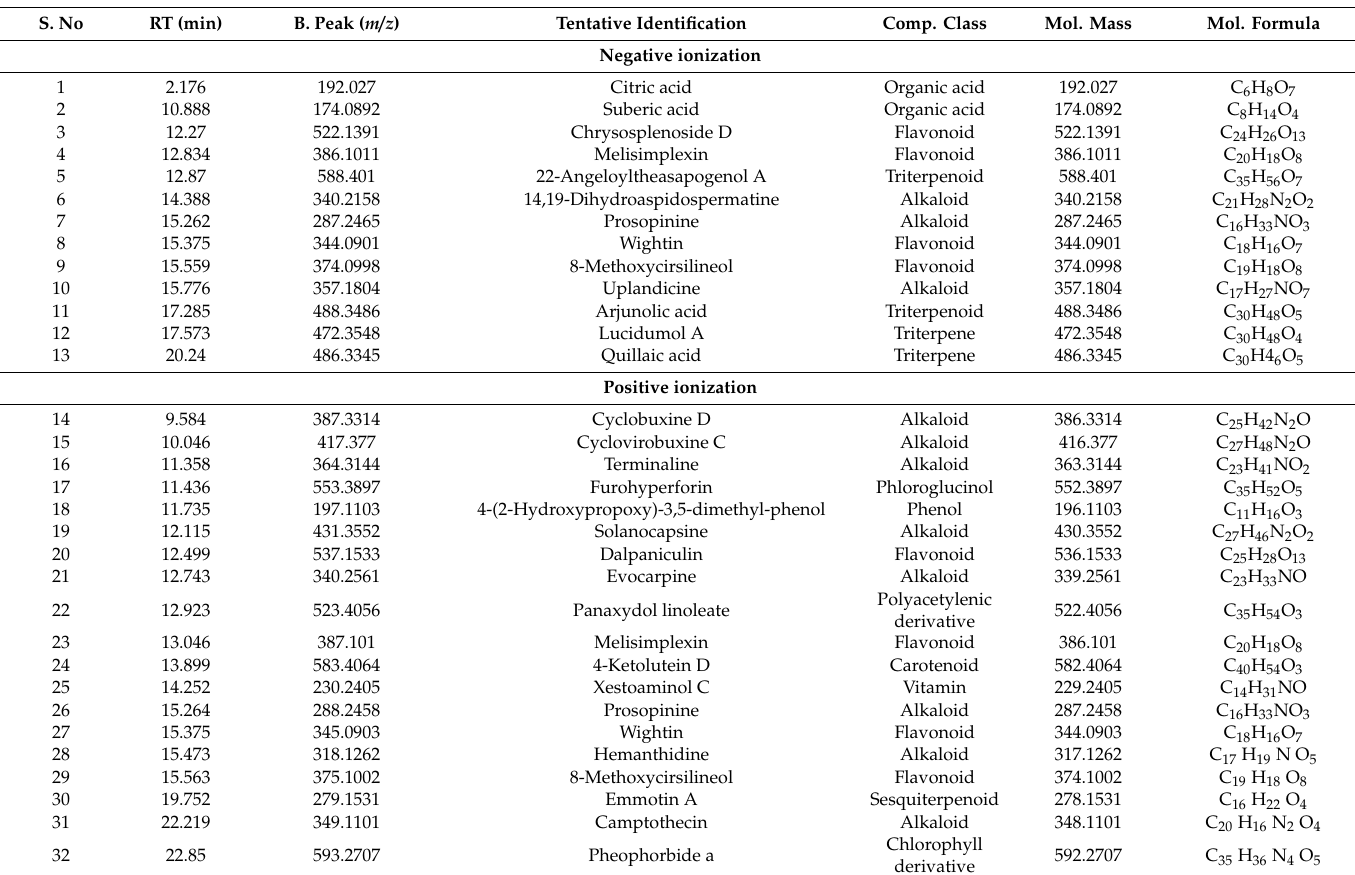
Table 3. UHPLC-MS secondary metabolites composition of B. papillosa stem DCM extract (negative and positive ionization